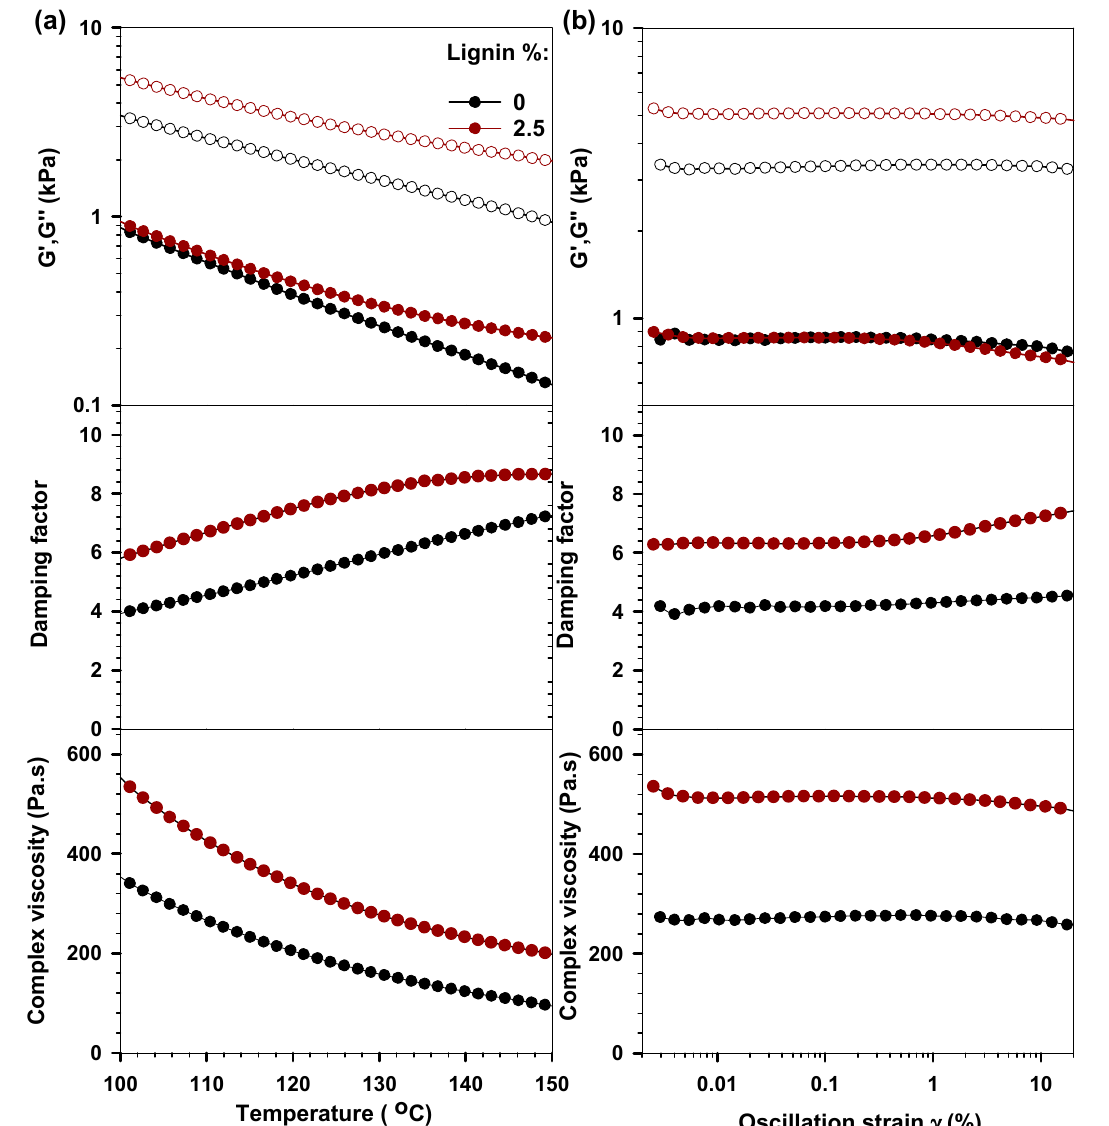
Figure 4. ( a ) The temperature-dependent variation of storage modulus, loss modulus, damping factor, and complex viscosity of pure PBS and composite with 2.5% lignin. ( b ) The oscillatory strain- dependent variation of storage modulus, loss modulus, damping factor, and complex viscosity of pure PBS and composite with 2.5% lignin at 110 °C.